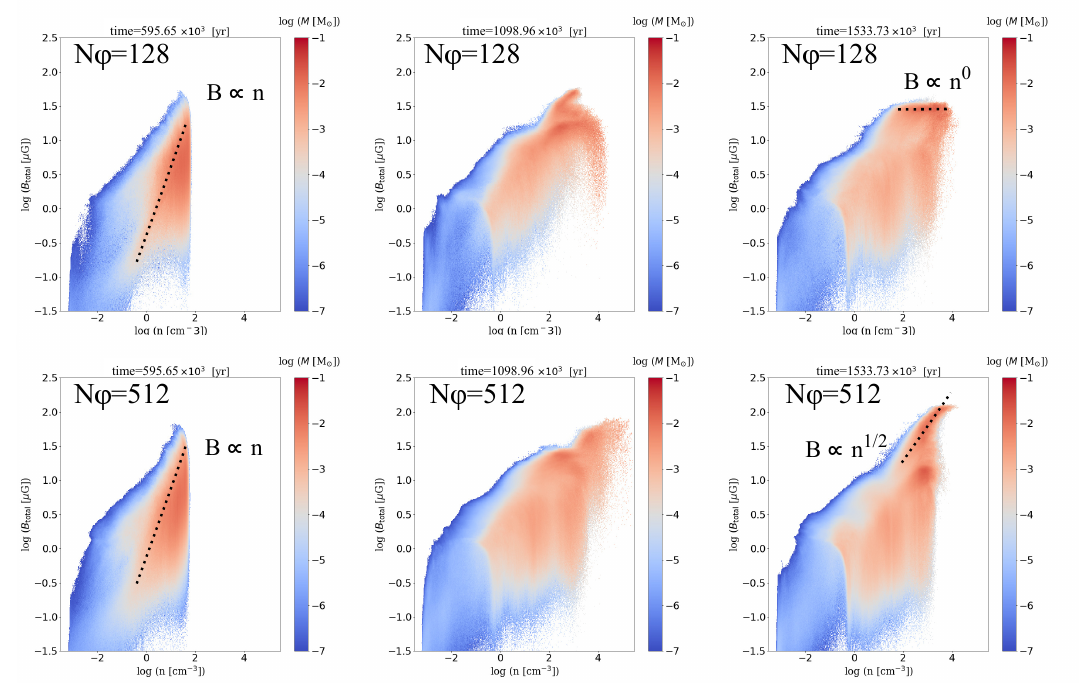
(cid:113) B 2 r + B 2 ϕ + B 2 z and number density n . Color Figure 5. 2D histogram of total field strength B total = contour denotes the mass occupying cells of ∆ ( log n ) = ∆ ( log B total ) =0.01. Top panels show the low resolution model and the bottom panels show the high resolution model. Left : t = 0.60 [Myr] of 20 rotation periods in the pure MHD; Middle : t = 1.10 [Myr] of 37 rotation periods in the MHD including cooling and heating effects; Right : t = 1.53 [Myr] of 52 rotation periods.